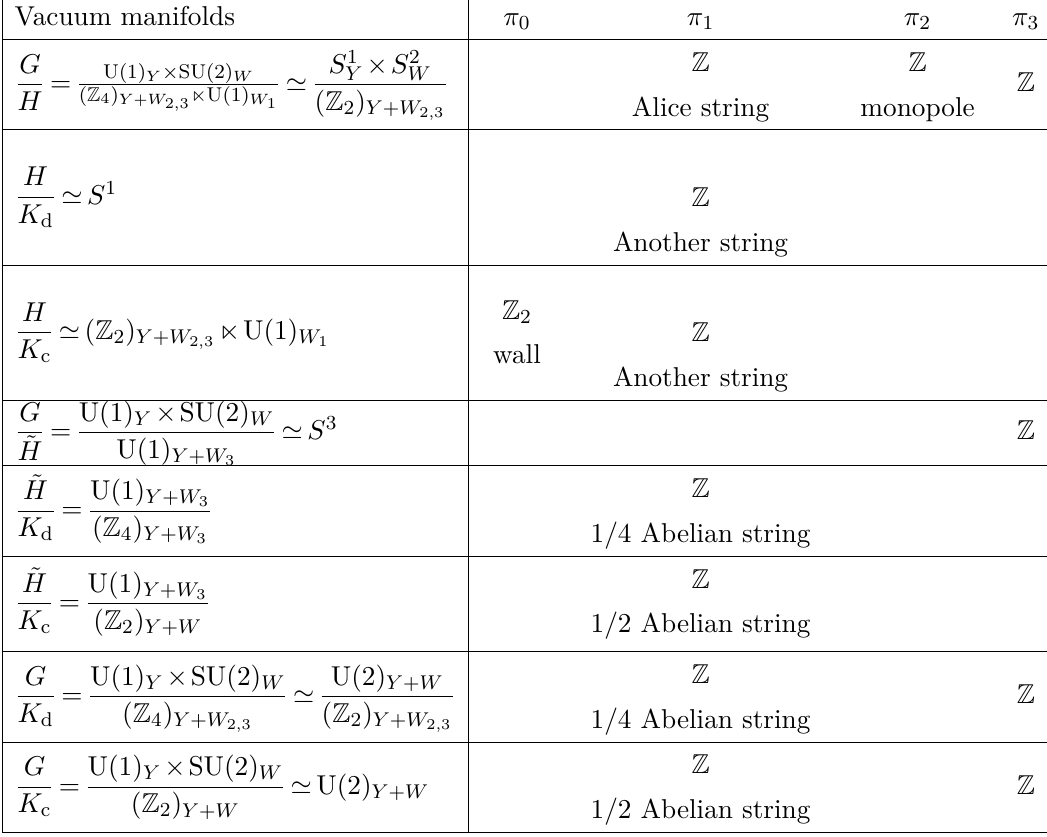
Table 1 . Vacuum manifolds and corresponding lower dimensional homotopy